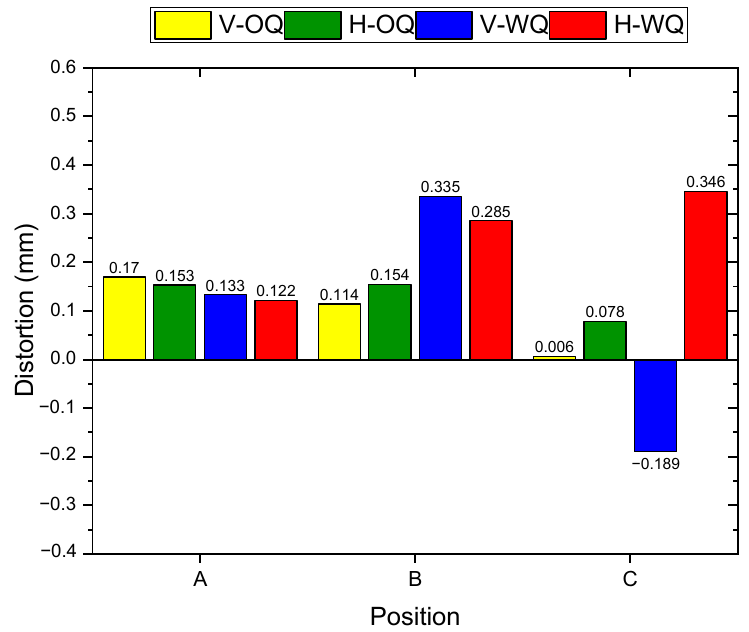
Figure 14. Simulated distortion after quench.